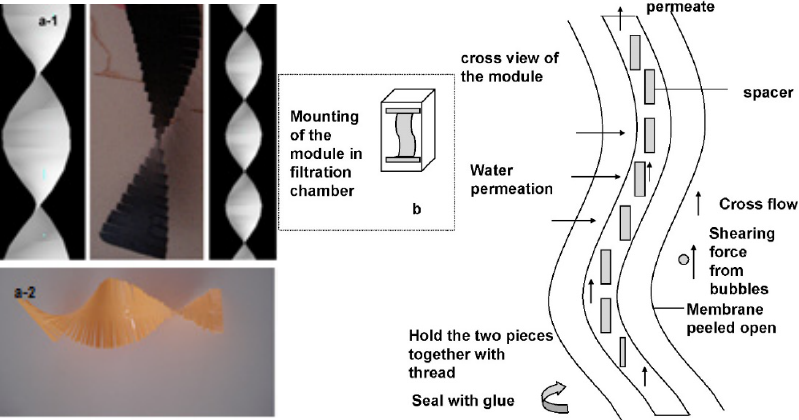
Figure 12. ( a-1 , a-2 ) the fish-bone or broom-like structure of spacer ( b ) cross view of helical mem- brane and its mounting in filtration chamber. Adapted from [172] with permission from Elsevier, 2010.